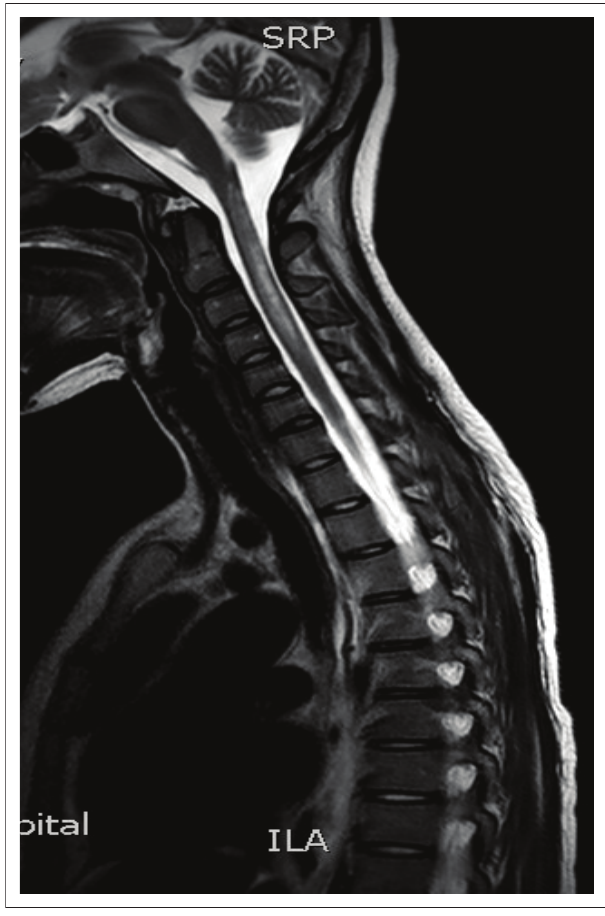
FIGURE 1: Sagittal T2-weighted magnetic resonance image depicting a hyperintense longitudinally extensive spinal cord lesion extending from the cervicomedullary junction to the C4 vertebra.